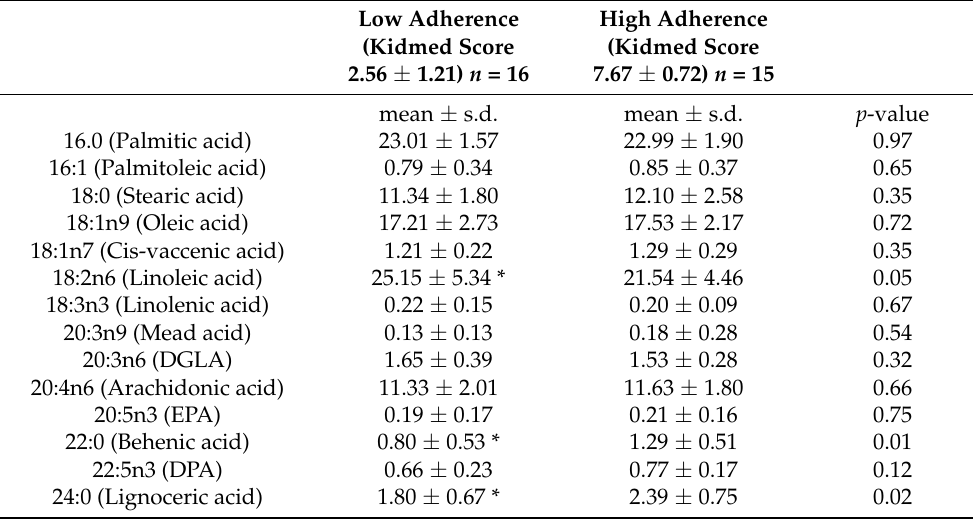
Table 4. Fatty acid profile of patients with low or high adherence to the Mediterranean